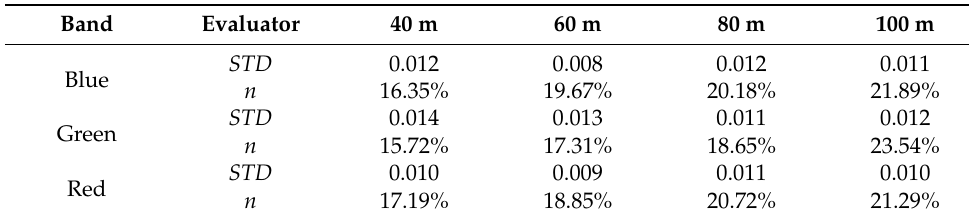
Table 3. The STD and n of the R ws in visible bands using four different tile sizes with spatial method (40, 60, 80 and 100 m), respectively.